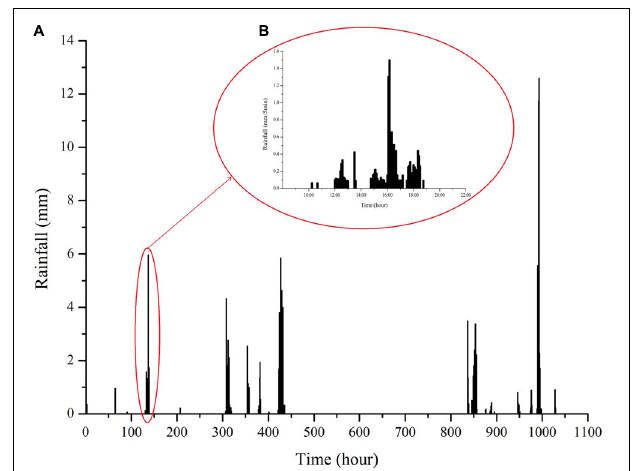
FIGURE 4 | Monthly precipitation changes in Guyuan City from 1985 to 2015.